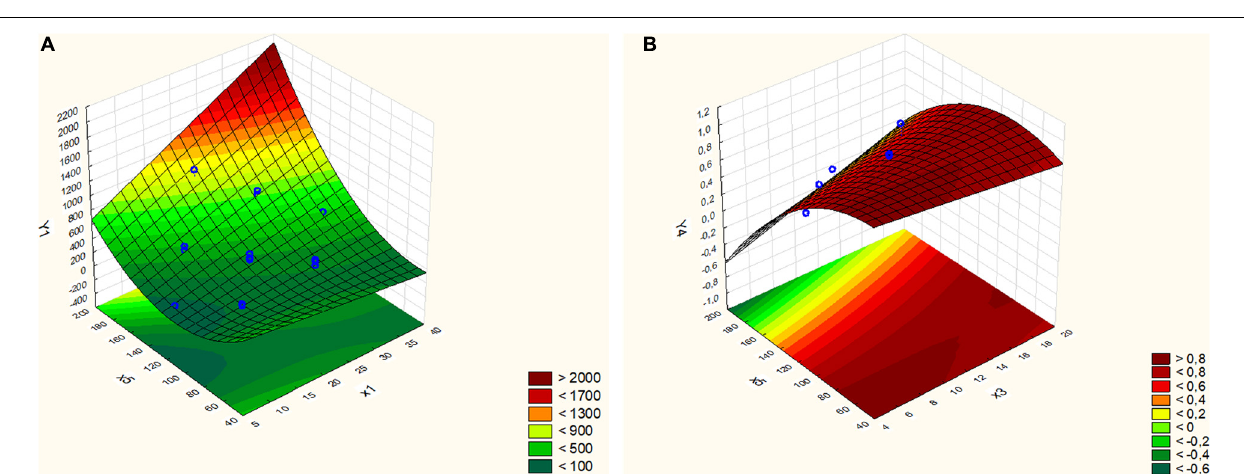
FIGURE 7 | (A) Surface plot for Y1 – Length of full aluminum head [mm] and (B) surface plot for Y4 – Fraction of CCA rod